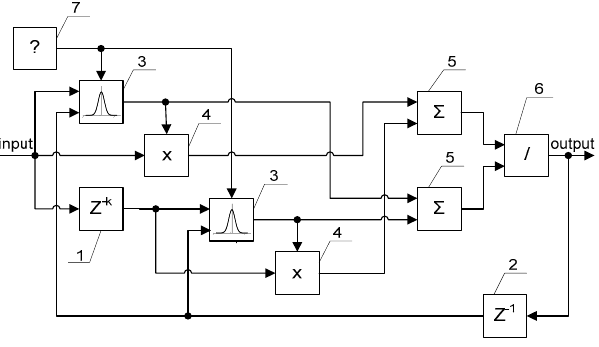
Figure 1. Basic principle of filter operation for k samples of the non-filtered signal.